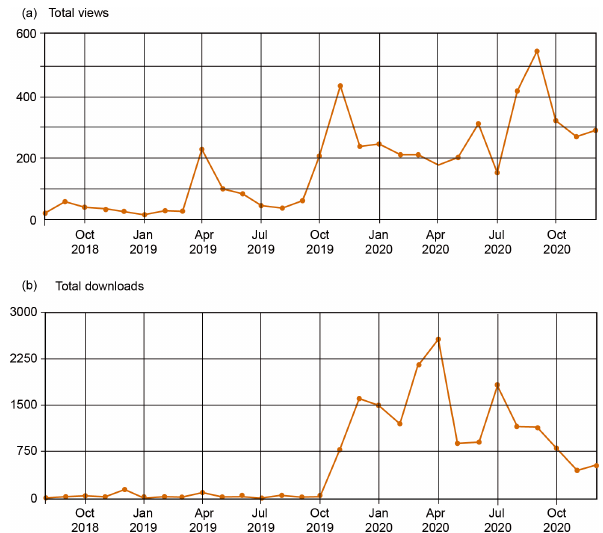
Figure 1. (a) Total views and (b) total downloads of all datasets from SeisDARE (https://digital.csic.es/handle/10261/101879, last access: January